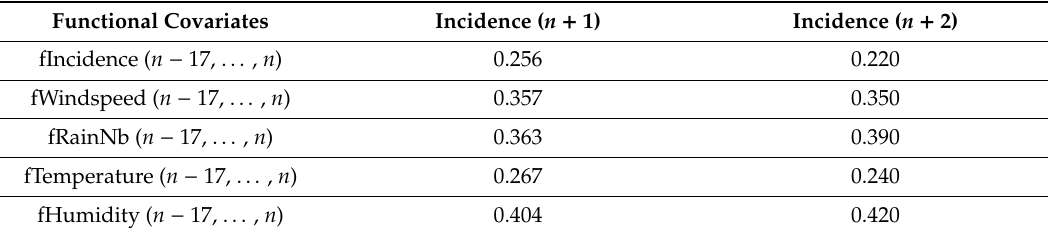
Table 1. The distance correlation among the functional covariates and the response at week n + 1 and n + 2 d .